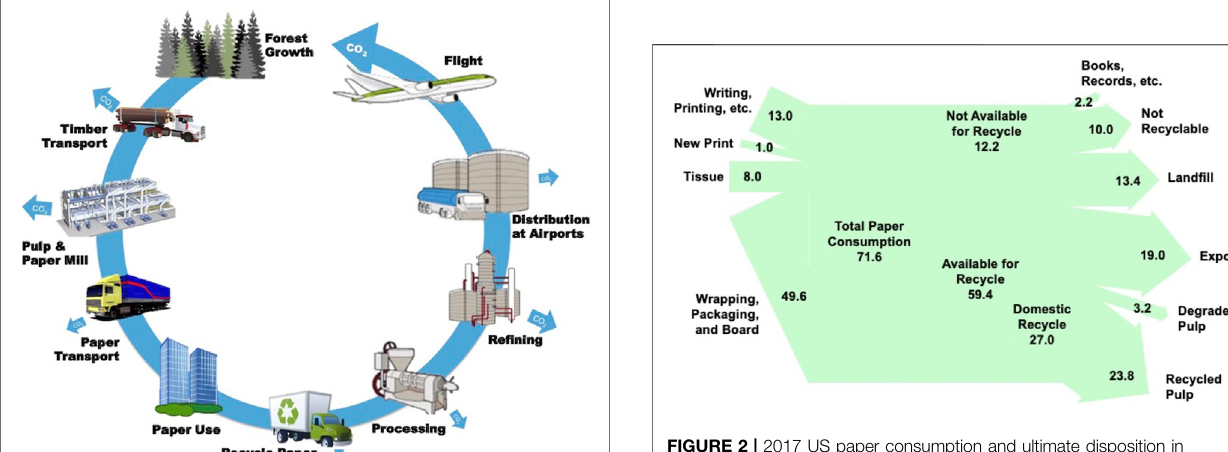
FIGURE 2 | 2017 US paper consumption and ultimate disposition in million annual tonnes. The diagram is based on information from (European Integrated Pollution Prevention and Control Bureau, 2001), (Food and Agriculture Organization of the United Nations, 2015), and (US Environmental Protection Agency,